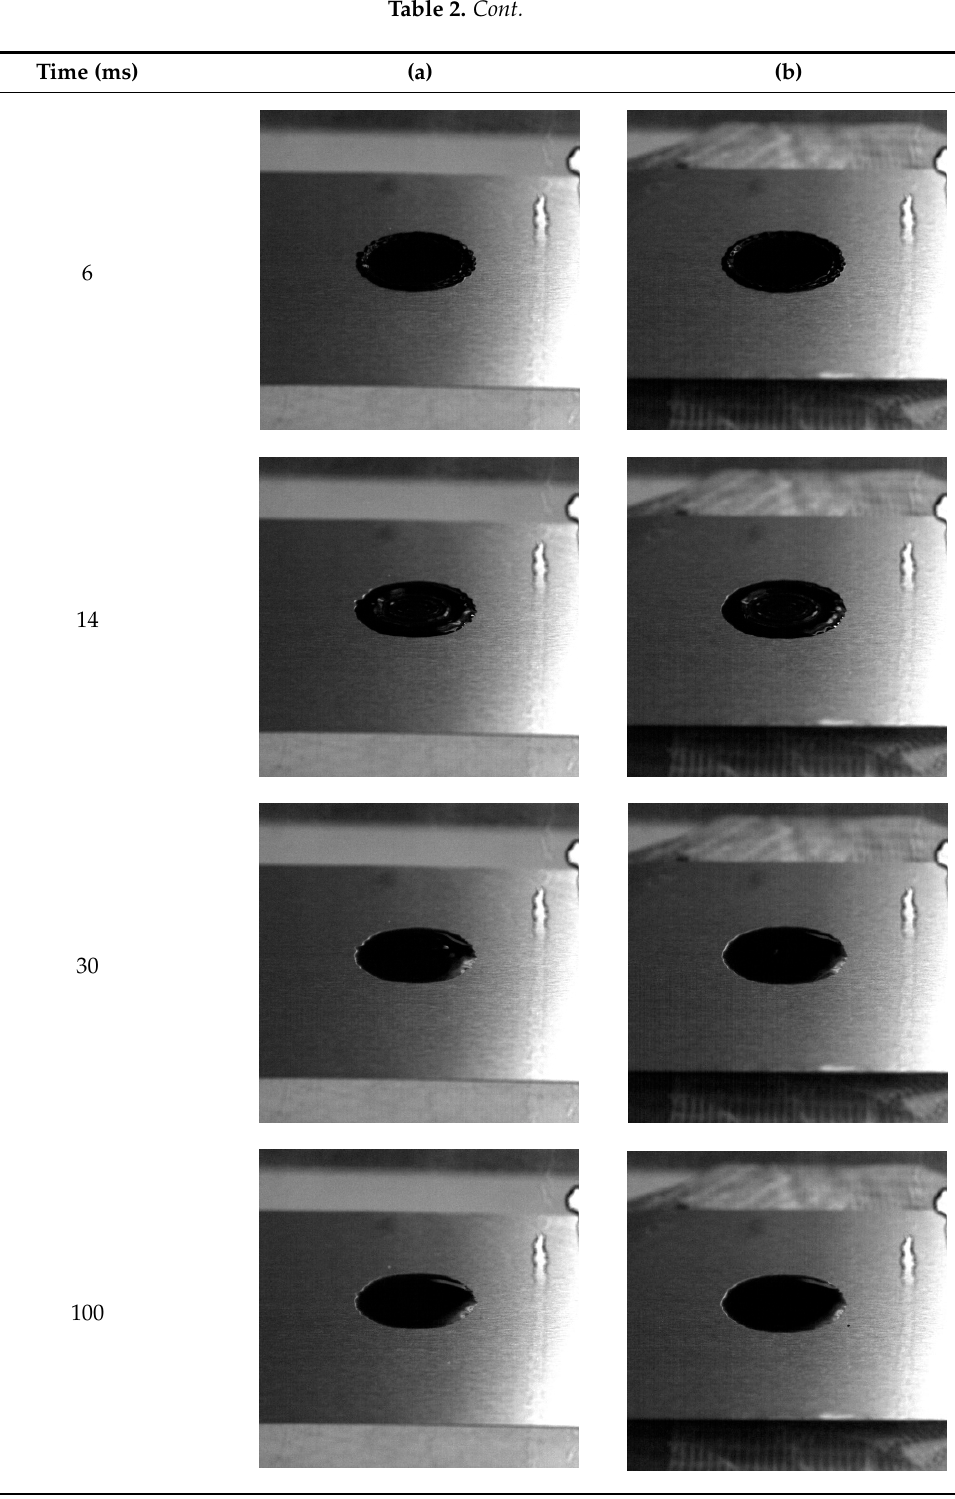
Figure 2. Reduced diameter versus magnetic field. 3.1. Effect of Surface Morphology The comparative results of magnetic nanofluid droplet impingement on unprocessed and processed surfaces without a magnetic field are illustrated in Table 2a,c. In general, both droplets will undergo impact with the surface, spread on the surface, extend to the maximum area, then retract, and finally stop after slight vibration. The bouncing behavior does not occur on the surface for each